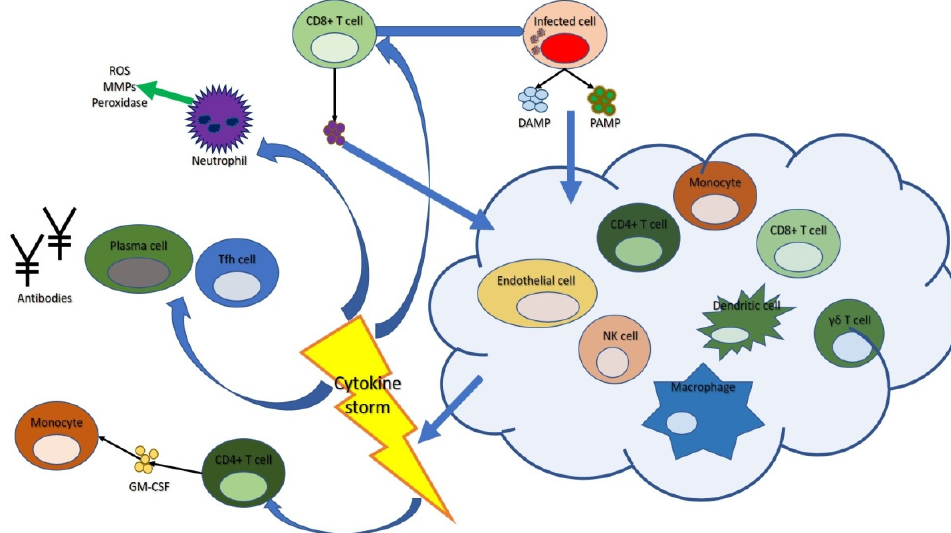
Figure 3. Viral dissemination during development of cytokine storm.